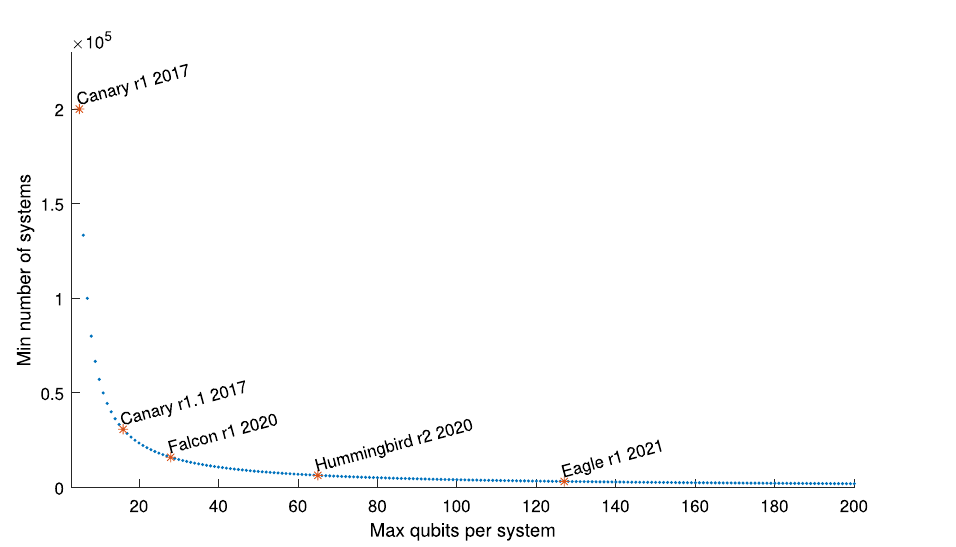
Figure 5. Minimal number of required systems to distribute a 400,000-controlled unitary using Algorithm 2 as required to factor a 2048-bit number using Shor’s algorithm, emphasizing the timeline of IBM quantum processors 14